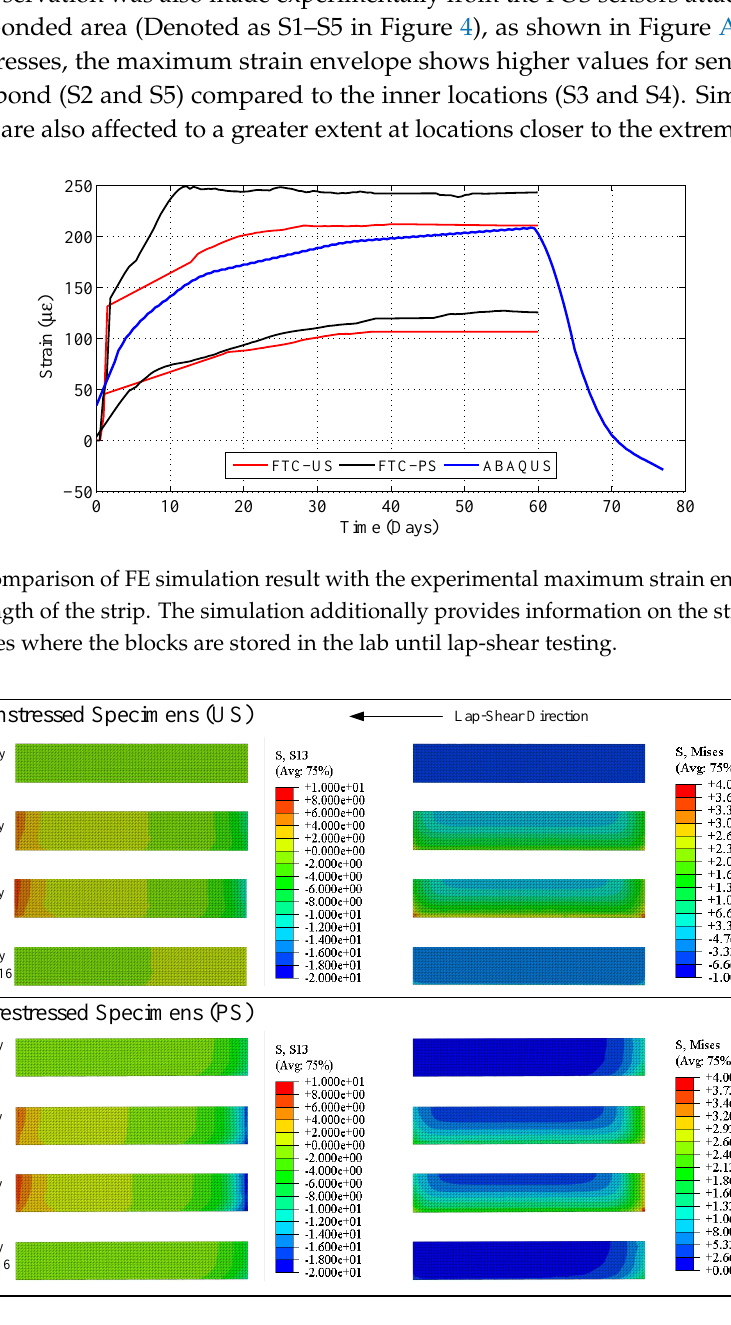
Figure 15. Interfacial shear stresses ( left ) and von Mises stresses ( right ) at the epoxy-concrete interface of unstressed ( top ) and prestressed ( bottom ) blocks at selected time steps. The axis of symmetry is at the top face of each contour